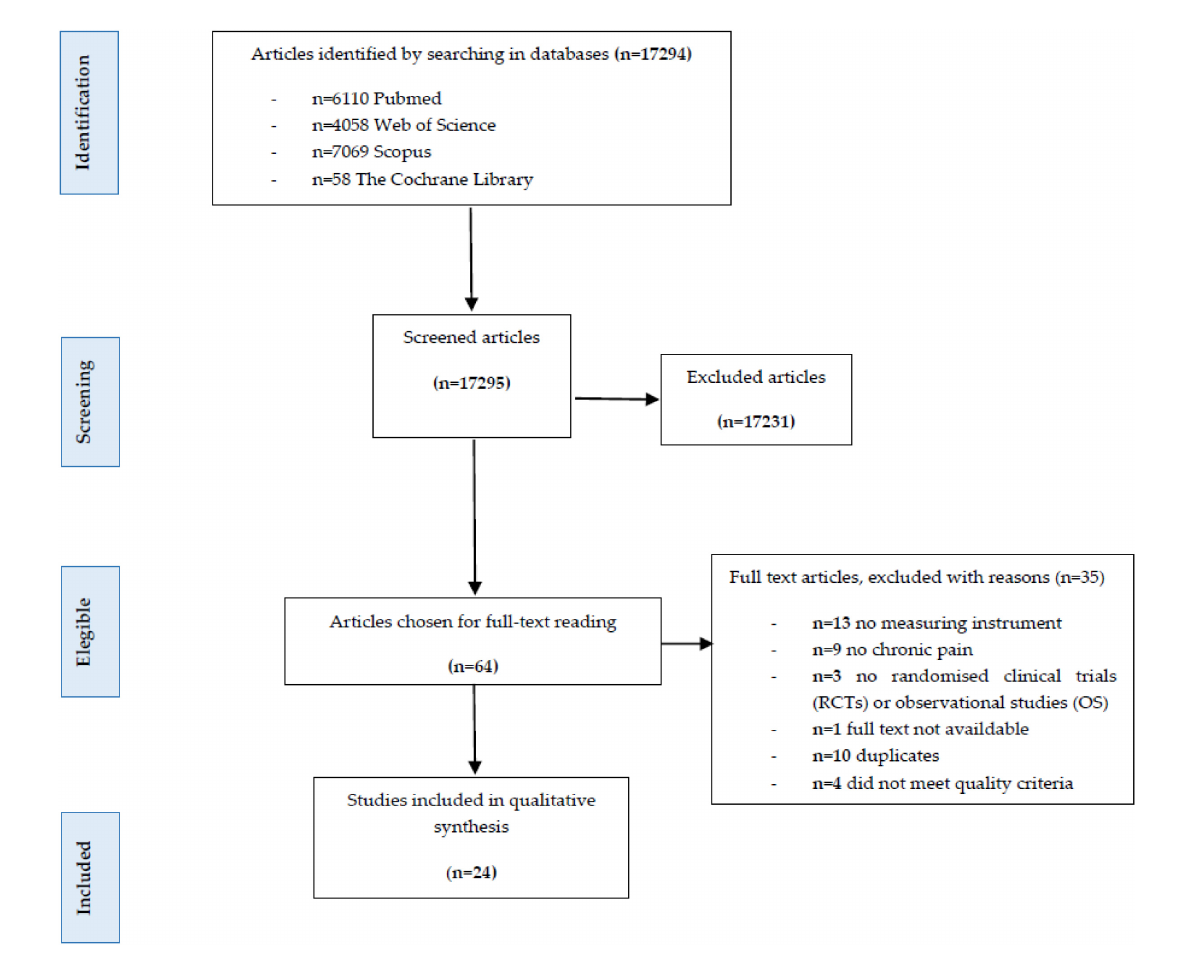
FIGURE1 Preferred reporting items for systematic reviews (PRISMA) flow